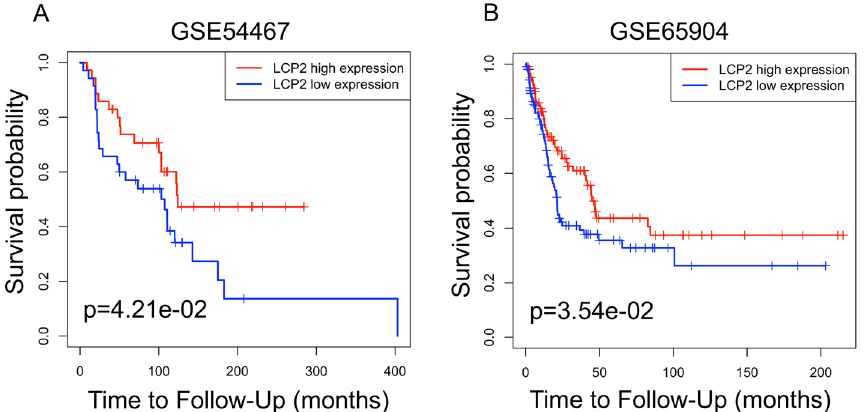
Figure 3. Prognostic value of LCP2 in melanoma. Kaplan–Meier curves display survival fraction for different LCP2 expression groups of patients based on GSE54467 ( A ) and GSE65904 ( B )